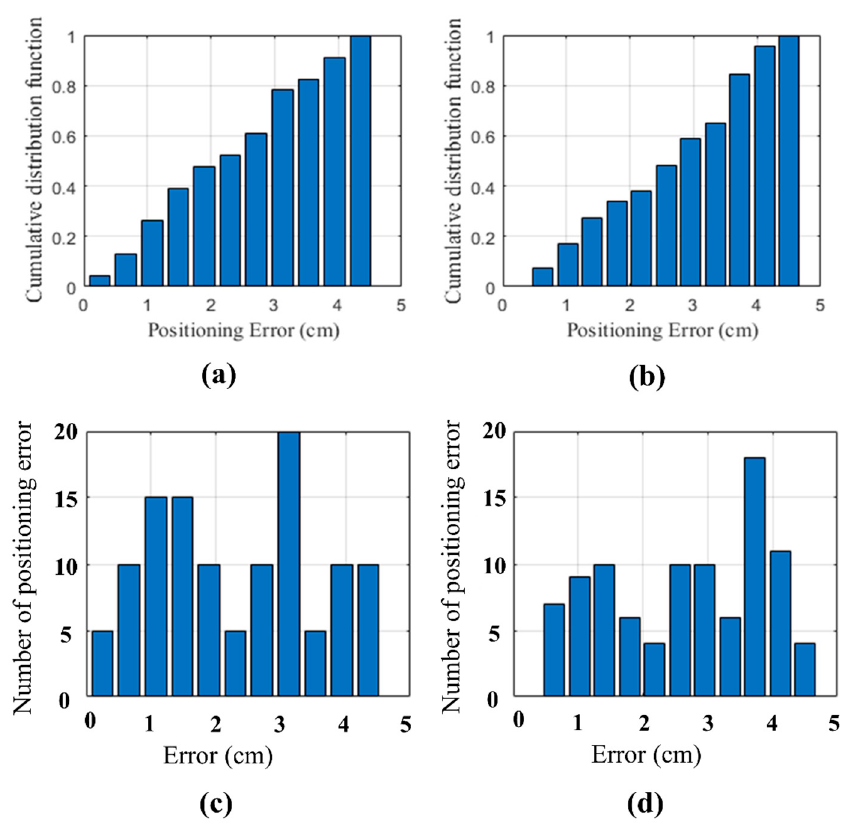
Figure 14. ( a ) CDF vs. error for evenly distributed test points; ( b ) CDF vs. error for randomly distributed test points; ( c ) histogram of error for evenly distributed test points; ( d ) histogram of error for randomly distributed test points.